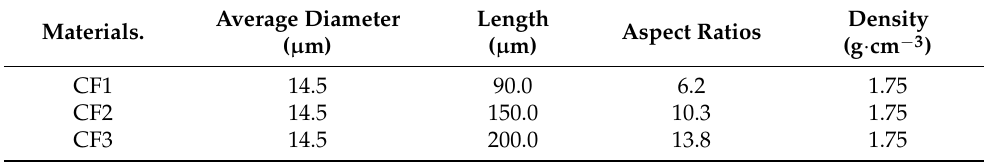
Table 1. Properties of three kinds of carbon